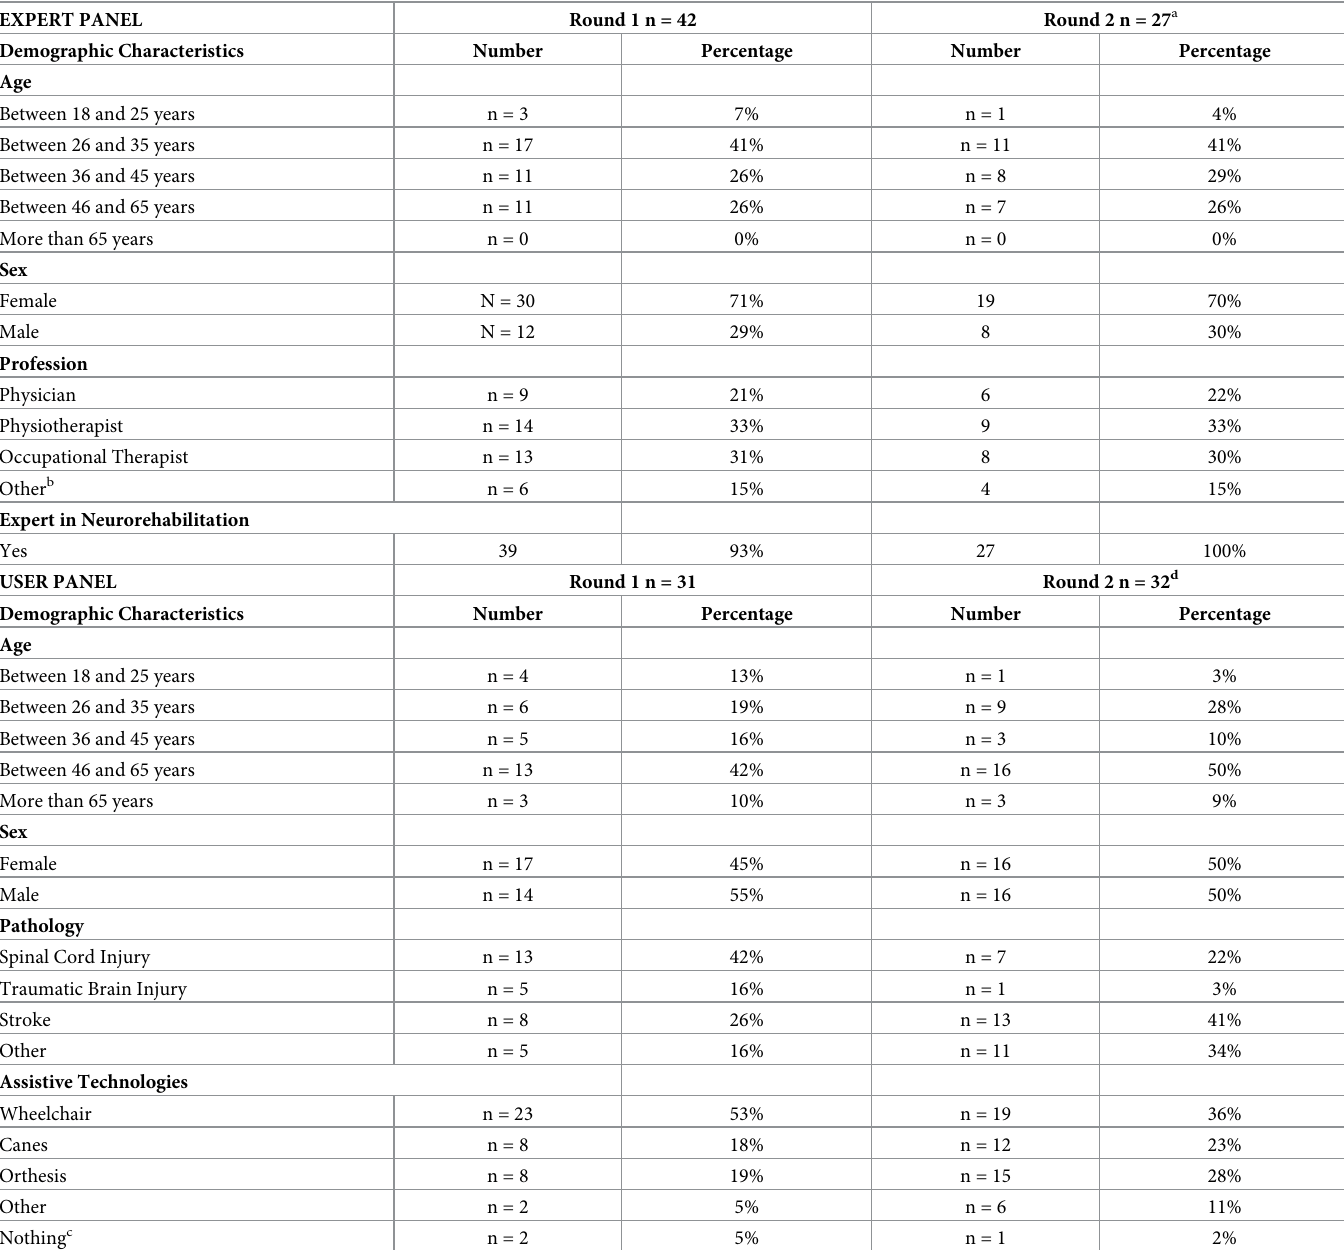
Table 1. Demographic characteristics of participants of the two rounds in the Delphi study. EXPERT